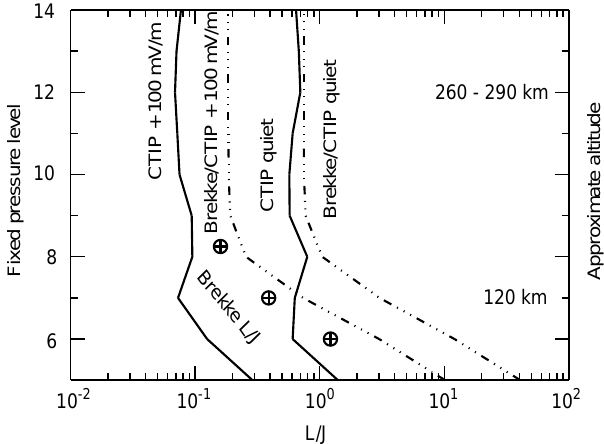
Fig. 3. Plot of the ratio of Lorentz forcing to Joule heating against height at latitude 70 (cid:14) N, longitude 162 (cid:14) E, Day 1. The two solid lines show the coupled model results for (a) quiet atmosphere, and (b) during the 100 mV/m enhanced electric field. The broken lines show results from the extrapolation of the Brekke formula, Eq. (4), for both quiet and enhanced atmospheres, whilst the three discrete points are the